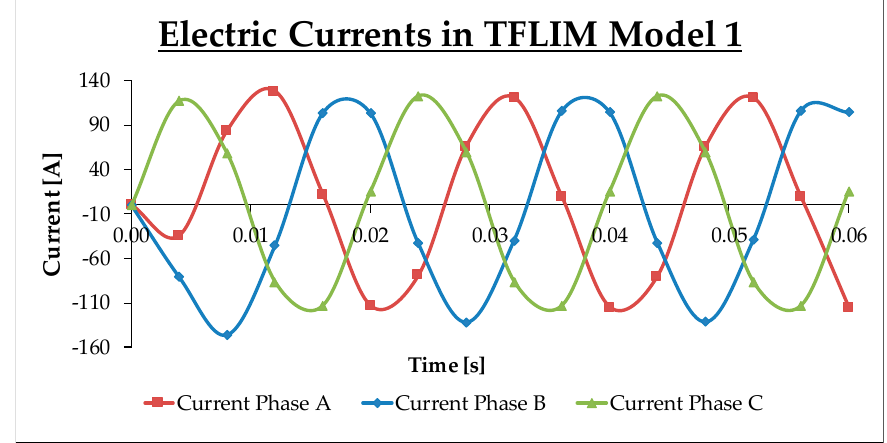
Figure 13. Electric current per phase in model 1.